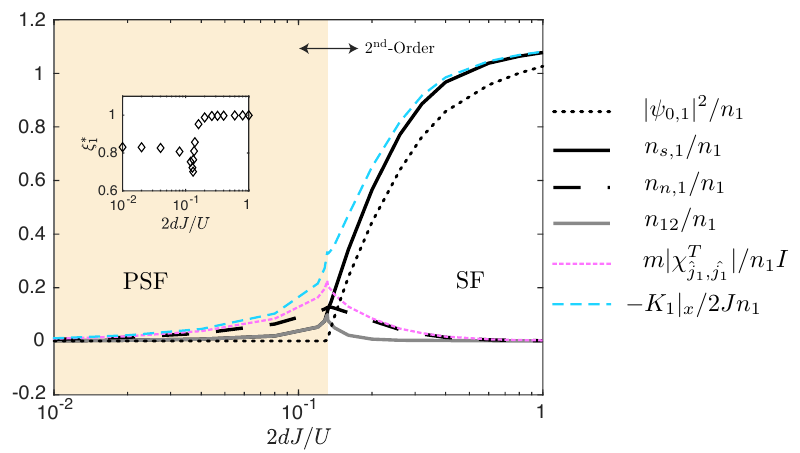
Figure 12: Transport quantities in two dimensions across the PSF-to-SF phase transi- = − 0.35 critical line, which separates the vacuum region from tion along the ( µ/ U ) c = 2 MI lobe for U / U = − 0.7, see Fig. 4(b). The one-component filling n the n d 12 include the corrections of the second-order quantum fluctuations. The tan-shaded area indicates the MI region. Thick black and grey lines indicate the QGW predic- tions for the superfluid density n and the superfluid drag n s ,1 black dashed and dotted lines refer to the normal component n | 2 . Pink dotted and blue dashed lines are the contributions to n fraction | ψ 0,1 | the average kinetic energy K and the intraspecies current response function χ T i x respectively. (Inset) Renormalization of the effective mass across the PSF transition due to the collisionless